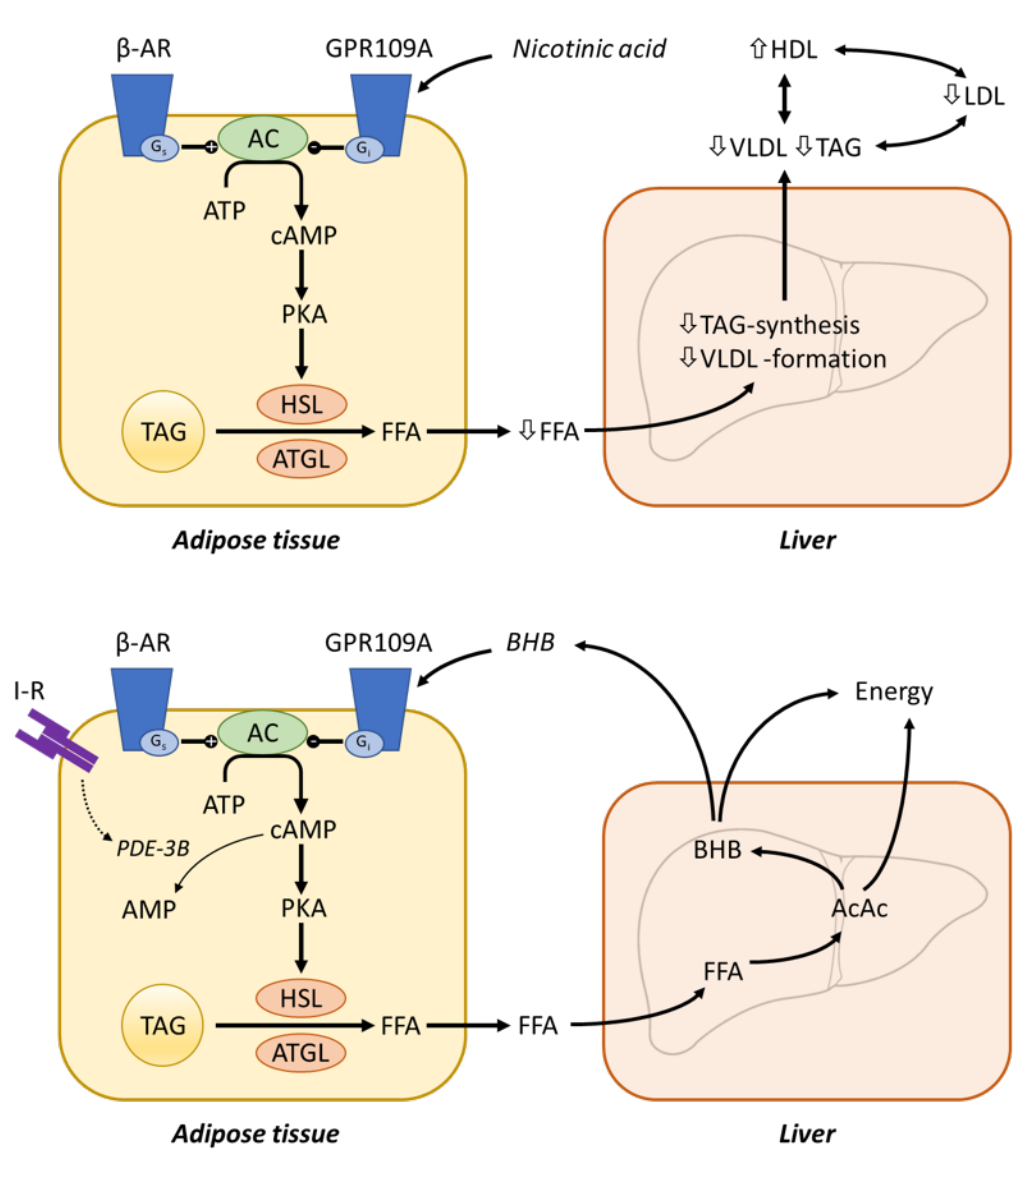
Figure 12. GPR109A receptor function. (upper panel) Metabolic effects of nicotinic acid. Activation of nicotinic acid receptor inhibits the mobilization of free fatty acids (FFA) from adipocytes and lowers the production of VLDL in hepatocytes with consequently decreased plasma levels of VLDL/LDL. TAG inhibit the cholesterol transfer to HDL via cholesteryl ester transfer protein (CETP). (bottom panel) Possible physiological role of GPR109A. In fasting, increased activity of the sympathetic nervous system and low insulin levels stimulate breakdown of TAG into FFA. Hepatic metabolism produces β -hydroxybutyrate (BHB) and acetoacetate (AcAc) as energy sources. BHB forms a negative feedback loop that limits the fat catabolism in adipose tissue.